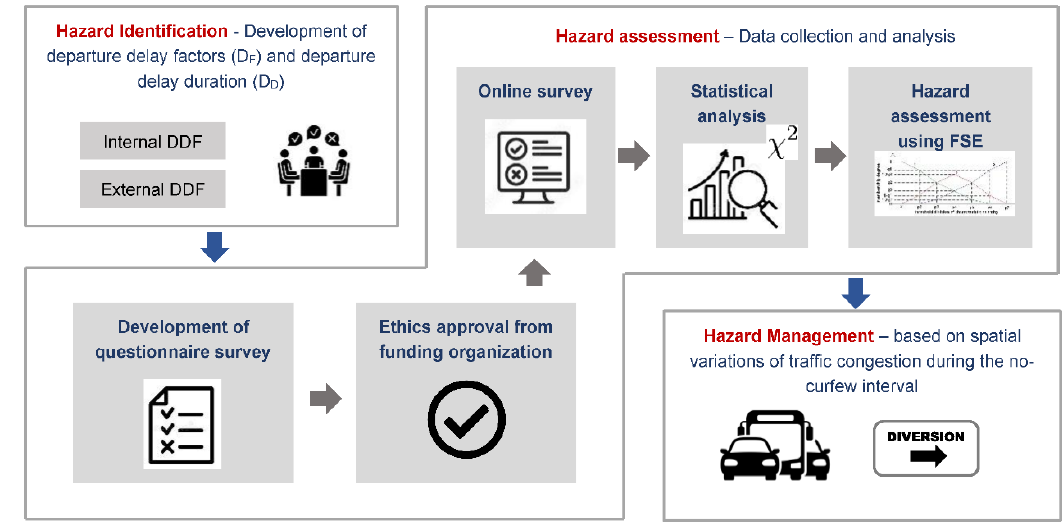
Figure 1. Vignette of Traffic Congestion Hazard Evaluation Framework.